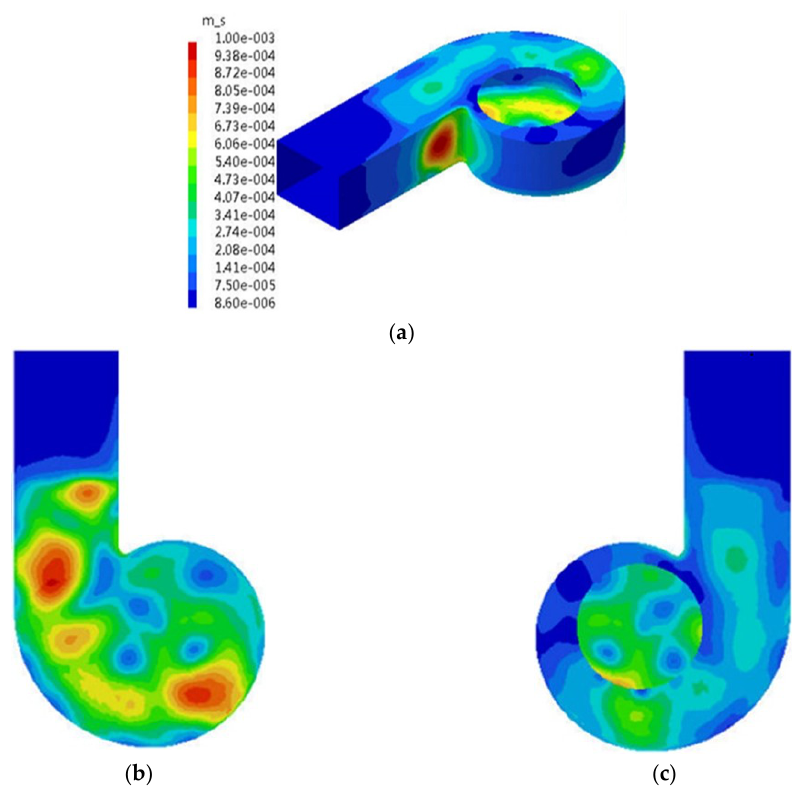
Figure 17. The distribution of the vibrational sound radiation of the volute casing surface at the fundamental blade-passing frequency (BPF). ( a ) Side; ( b ) Back; ( c ) Front. Appl. Sci. 2019 , 9 , x FOR PEER REVIEW